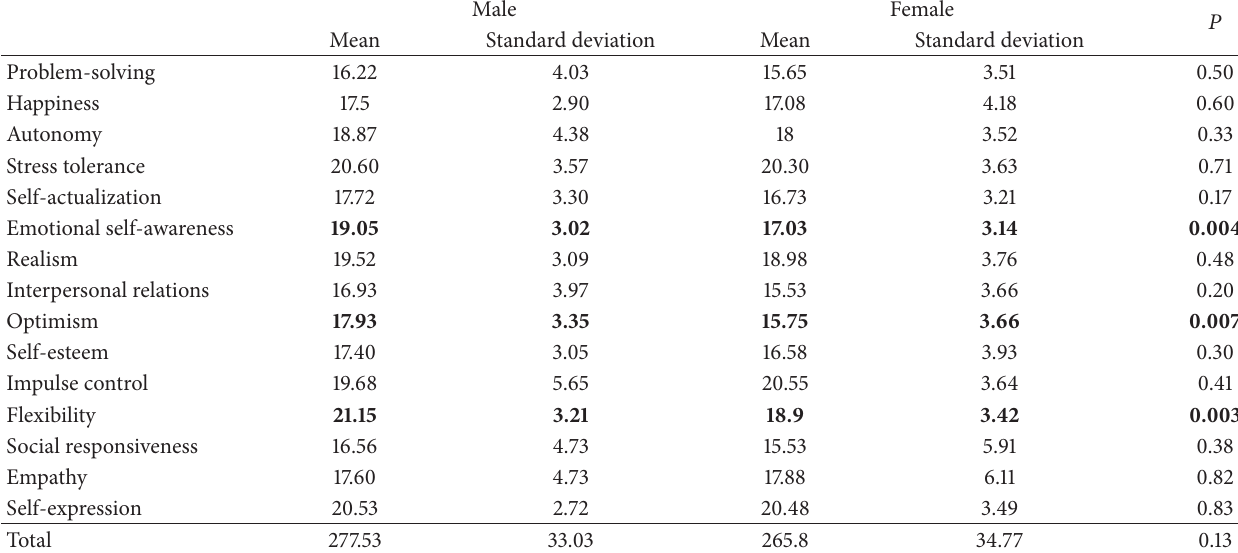
Table 4: Components of emotional intelligence in males and females with alcohol